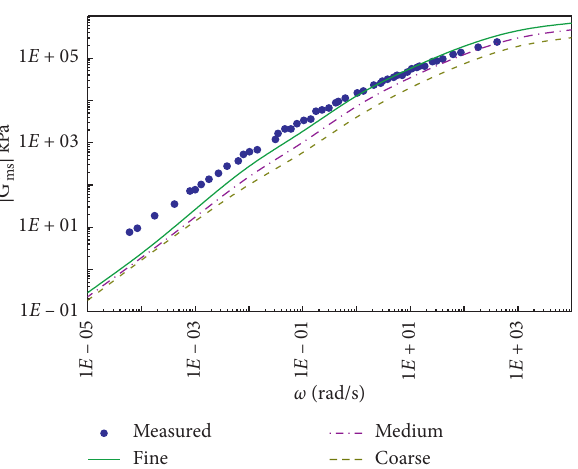
Figure 10: Effect of fillers gradation on predicted | G ∗